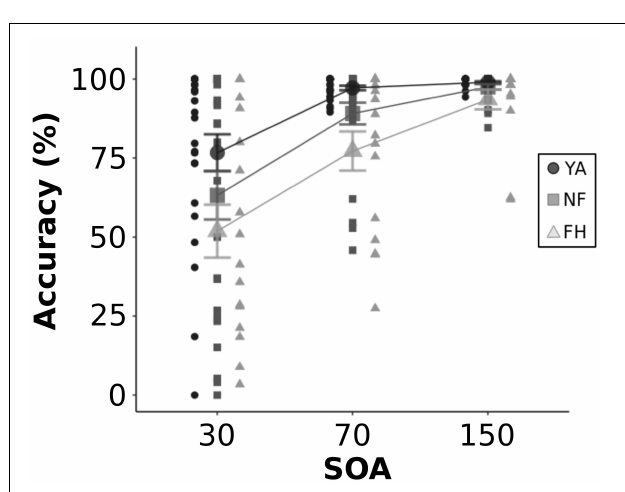
FIGURE 4 | Accuracy during 2F2B congruent trials. Individual and group-averaged values for perceptual accuracy in discriminating 2 veridical flashes during congruent trials are displayed for each SOA level. YA adults are represented by black circles, NF by dark gray squares, FH by light gray triangles. Error bars reflect standard